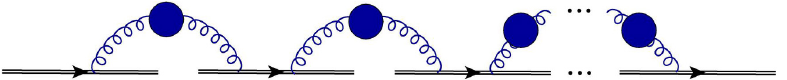
Figure 3. A Cweb constructed out of n two-point correlators connecting n + 1 Wilson lines. This is one of the basis Cwebs at order α n